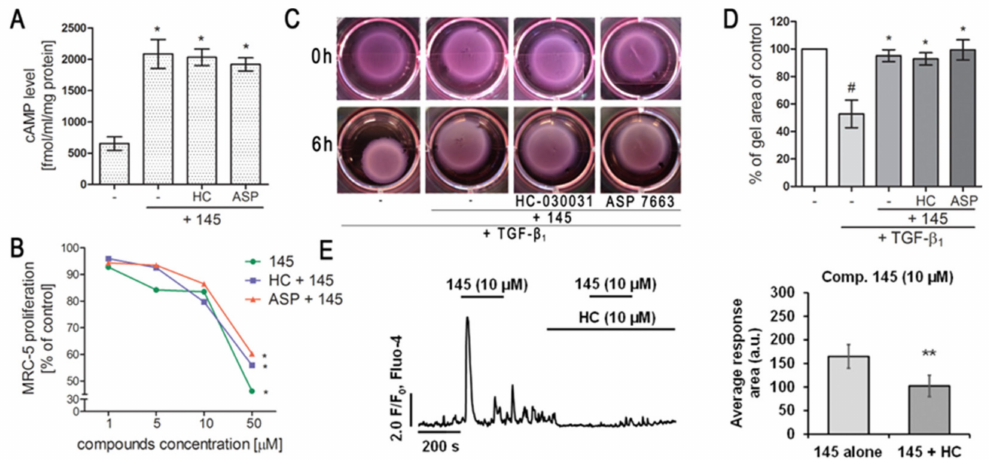
Figure 5. Modulation of TRPA1 channel activity does not a ff ect the anti-fibrotic properties of compound 145 in MRC-5 cells. ( A ) Lung fibroblasts were cultured for 24 h and then serum-deprived for 2